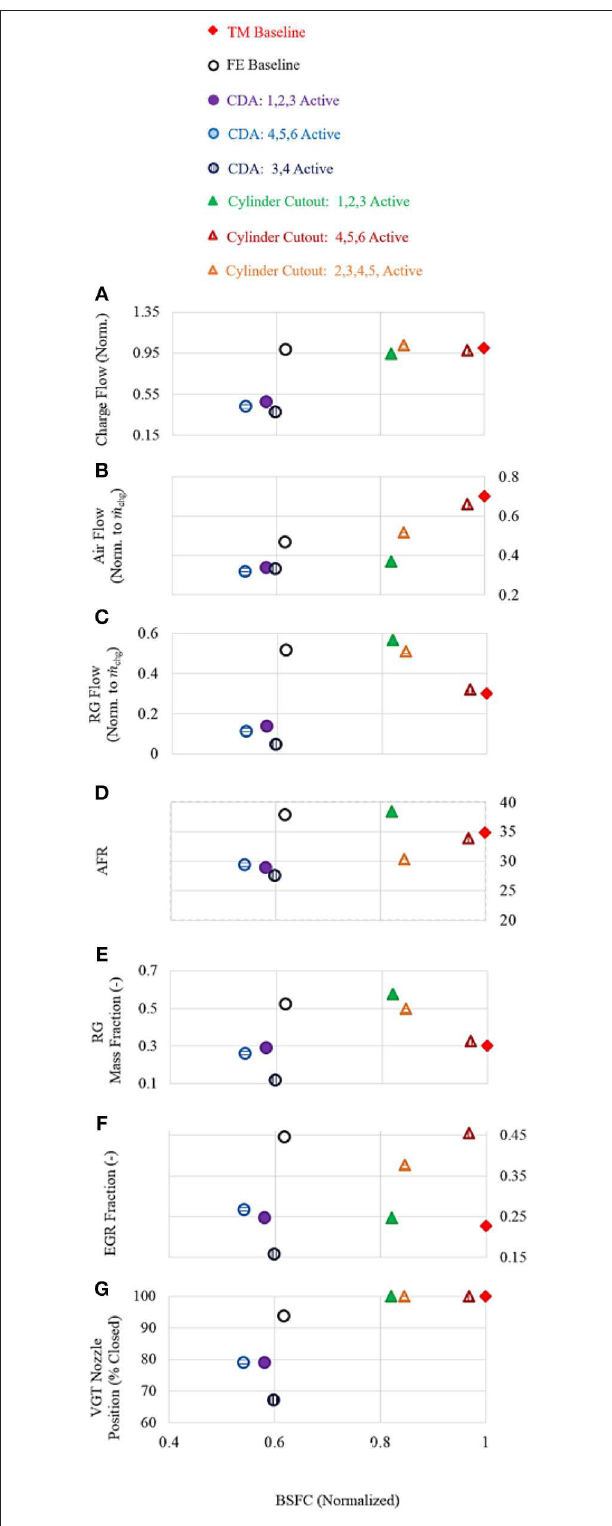
FIGURE 7 | (A) Charge flow through the engine normalized to the TMBaseline . (B) Airflownormalizedtothechargeflow TMBaseline . (C) RGflow